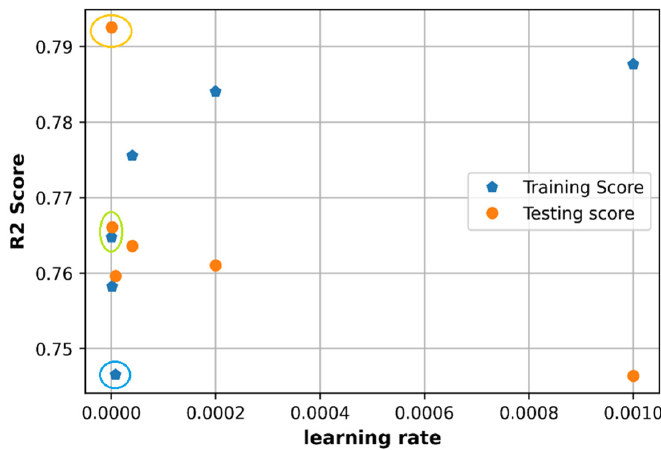
Figure 14. Comparison of accuracy with different learning rate.